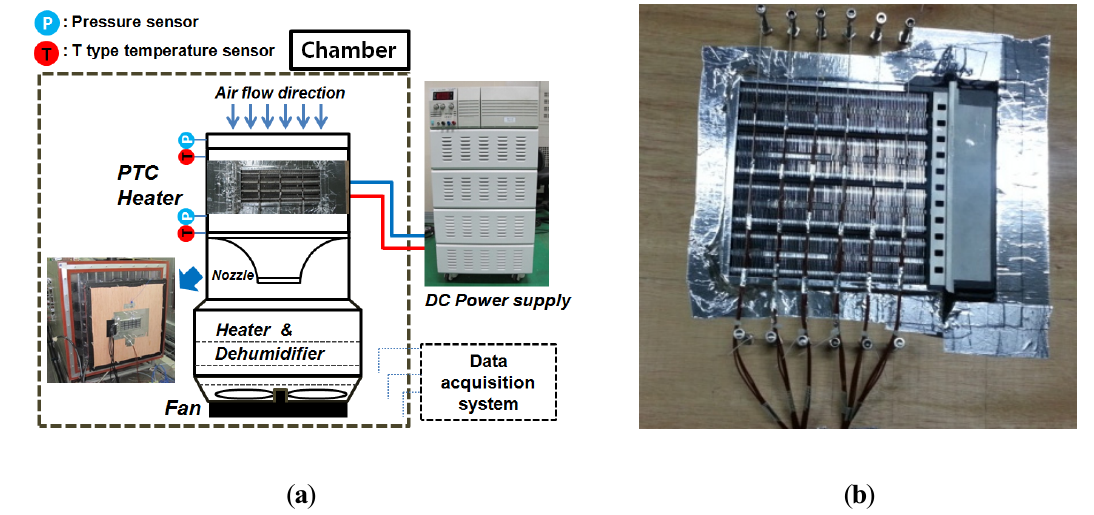
Figure 9. Schematic diagram of the test facility and prototype heating system used to evaluate the heating performance. ( a ) Schematic diagram of the test facility; ( b ) Installation of the prototype heating system. Table 7. Impact test conditions.